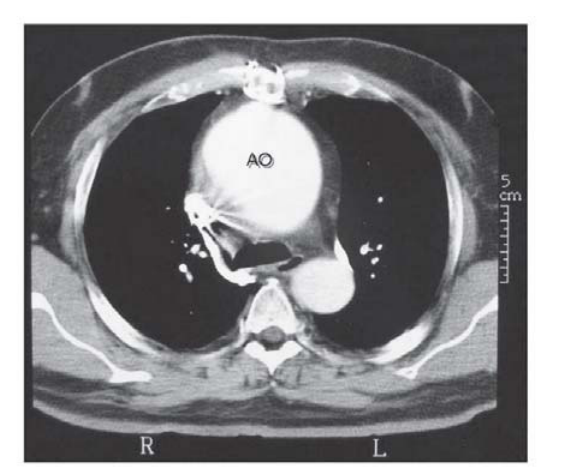
Fig. 2 - Transesophageal echocardiogram showing a severely dilated ascending aorta and a normal mechanical aortic valve